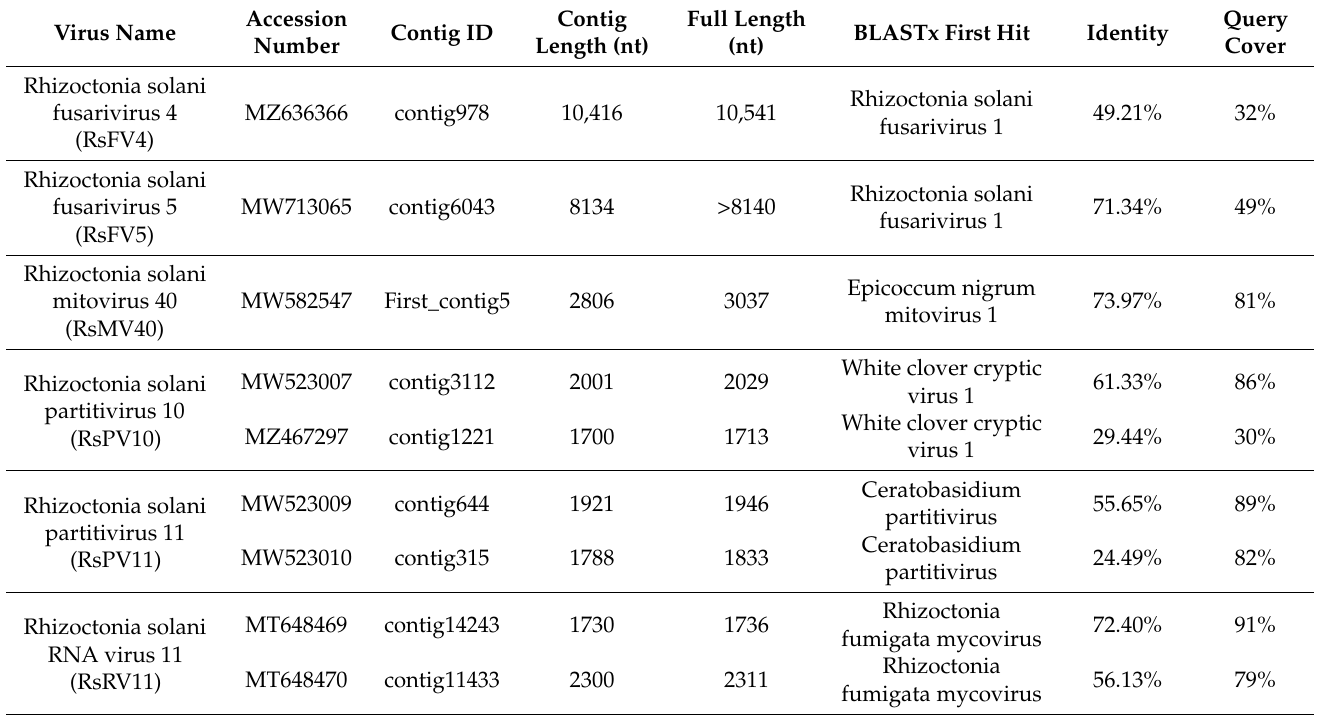
Table 1. Six novel mycoviruses identified in Rhizoctonia solani AG-3 PT strain ZJ-2H obtained through metatranscriptome sequencing and rapid amplification of cDNA ends